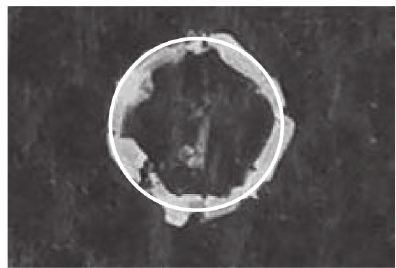
Figure 6: Schematic diagram of detection point location.